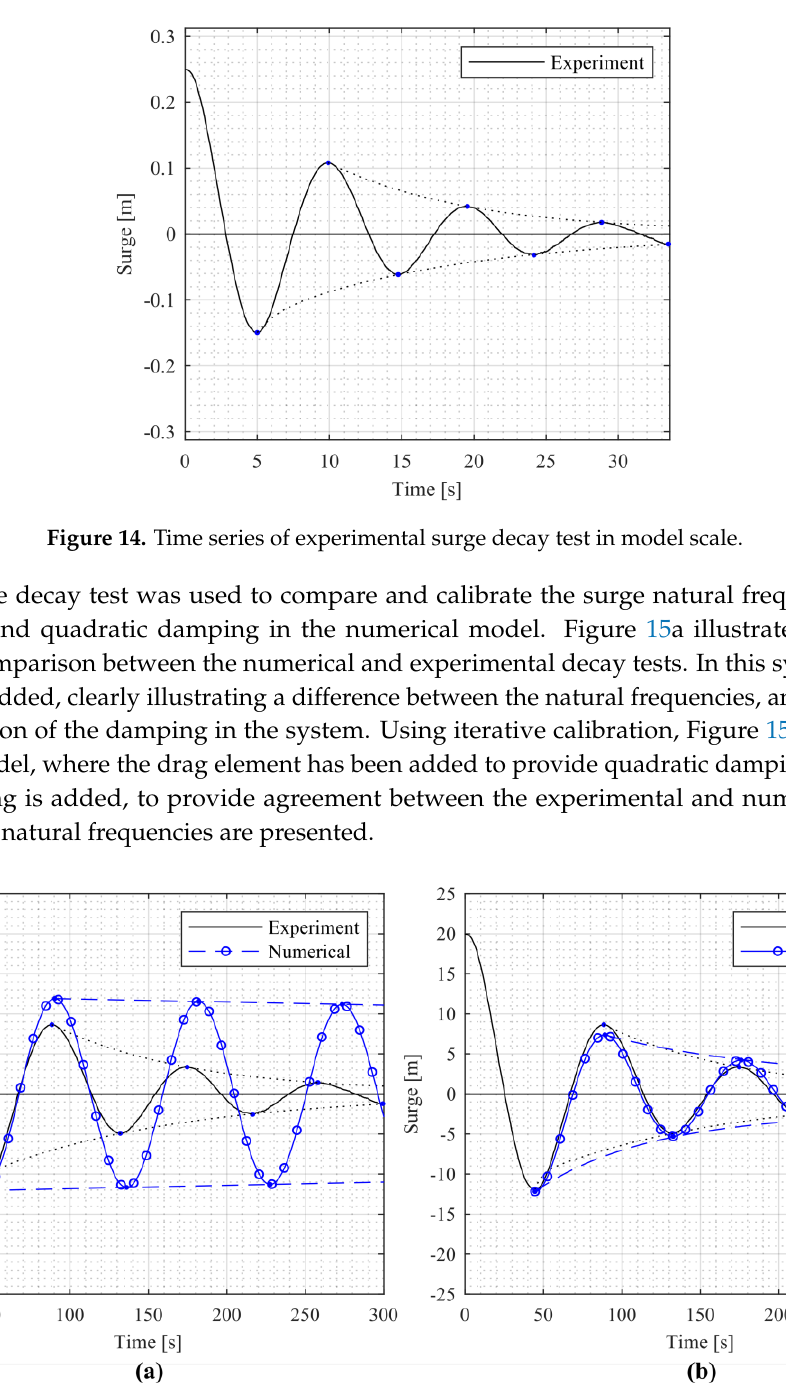
Figure 15. Comparison of experimental and numerical surge decay tests. ( a ) is without added drag and linear damping. ( b ) is the optimized model with Morison drag elements and added linear damping. Table 4. Experimentally and numerically determined natural periods in surge (full scale).